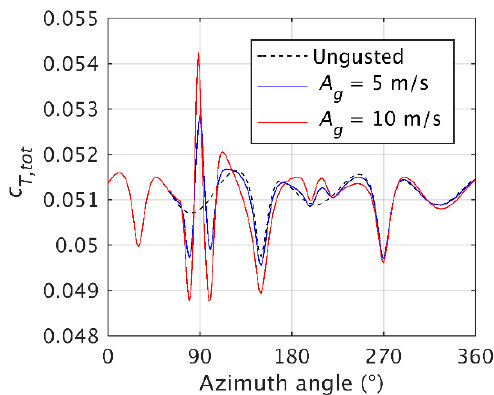
Figure 12. Zero net flow rate gusts: total torque provided by the machine as a function of the azimuth angle of the blade hit by the gust.